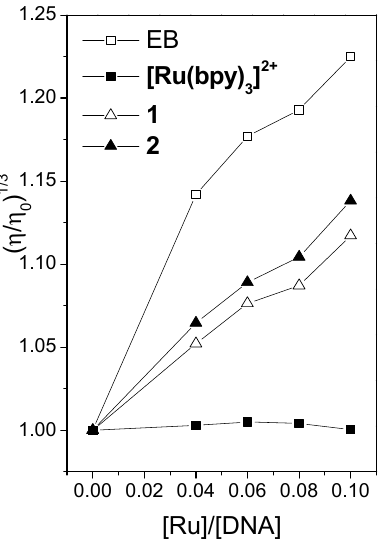
Figure 2. Comparison of DNA (0.25 mM) viscosity of the compounds. [Ru]/[DNA] = 0, 0.04, 0.06, 0.08, 0.1.